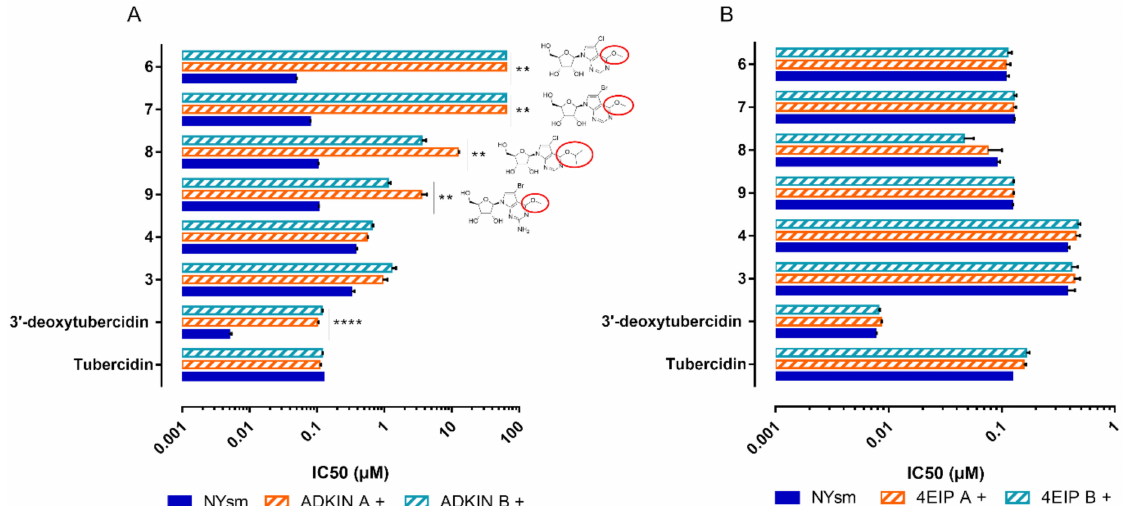
Figure 4. Susceptibility of ADKIN ( A ) and 4EIP ( B ). RNAi-mediated knockdown to compounds 1 – 4 , and 6 – 9 . Results are expressed as the mean IC 50 ( µ M), and error bars represent SEM and are based on at least two independent experiments ( n = 2), each with two biological replicates. + = tetracycline-induced clones. All experiments were performed with two independently generated RNAi clones. ** p <0.01,**** p < 0.0001, Mann–Withney test comparing NY-SM with RNAi knock-down strains. ADKIN 3 (cid:48) -deoxytubercidin data was previously published